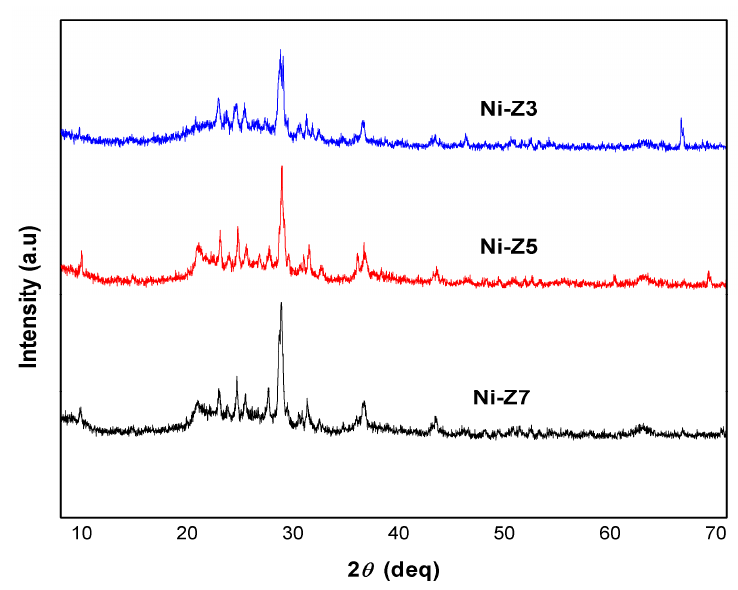
Figure 7. XRD diffractogram patterns of Ni-Z3, Ni-Z5, and Ni-Z7. Figure 7. XRD di ff ractogram patterns of Ni-Z3, Ni-Z5, and Ni-Z7.